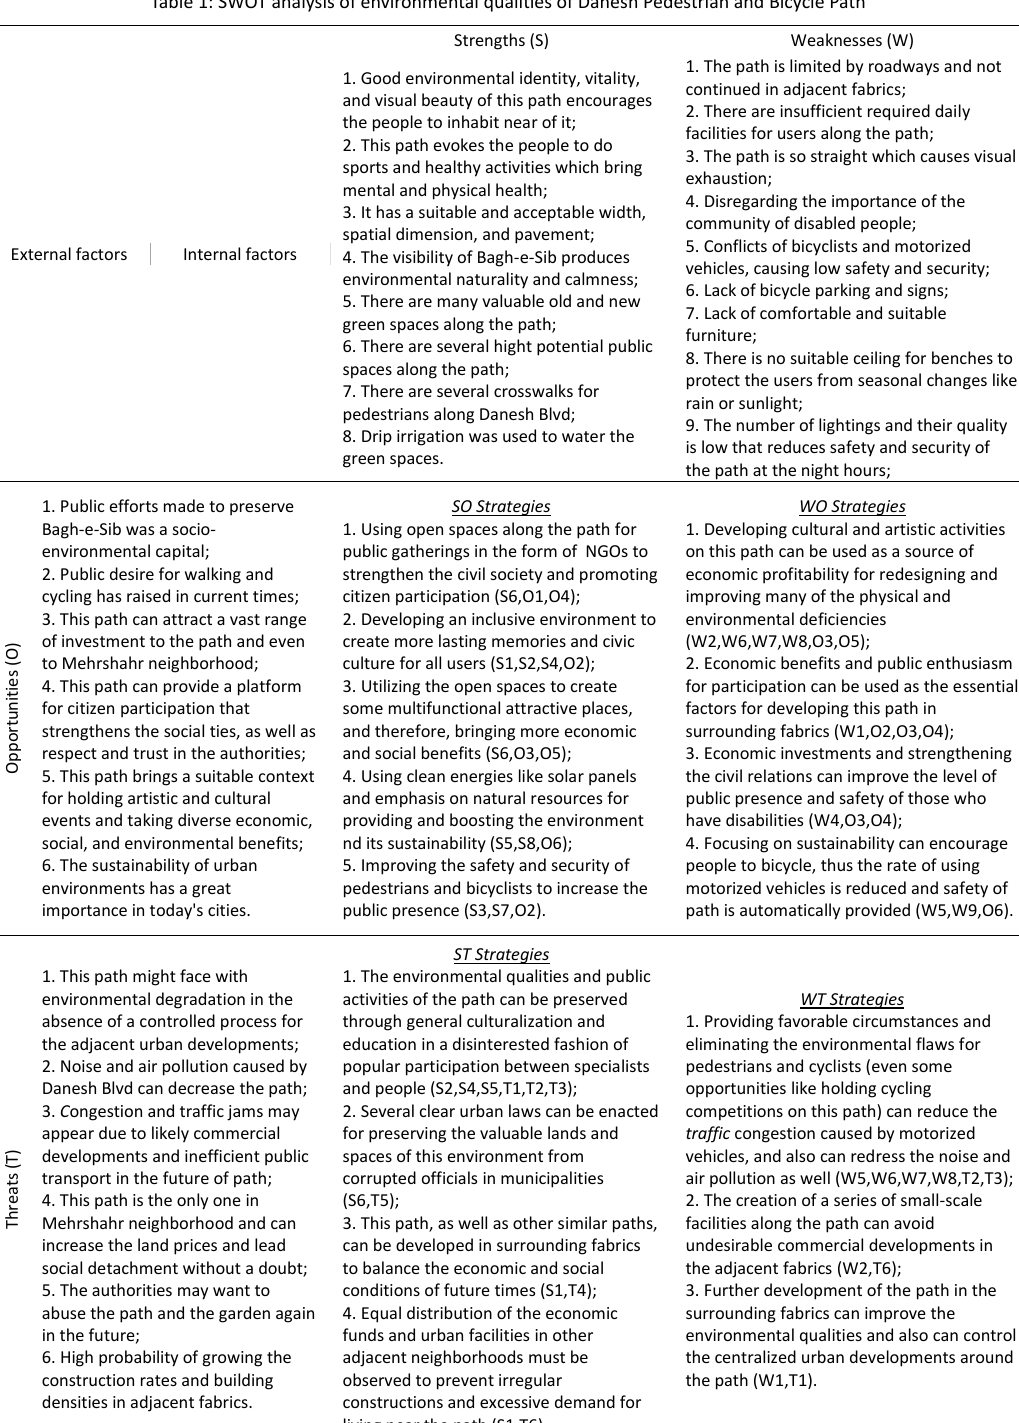
Table 1: SWOT analysis of environmental qualities of Danesh Pedestrian and Bicycle Path